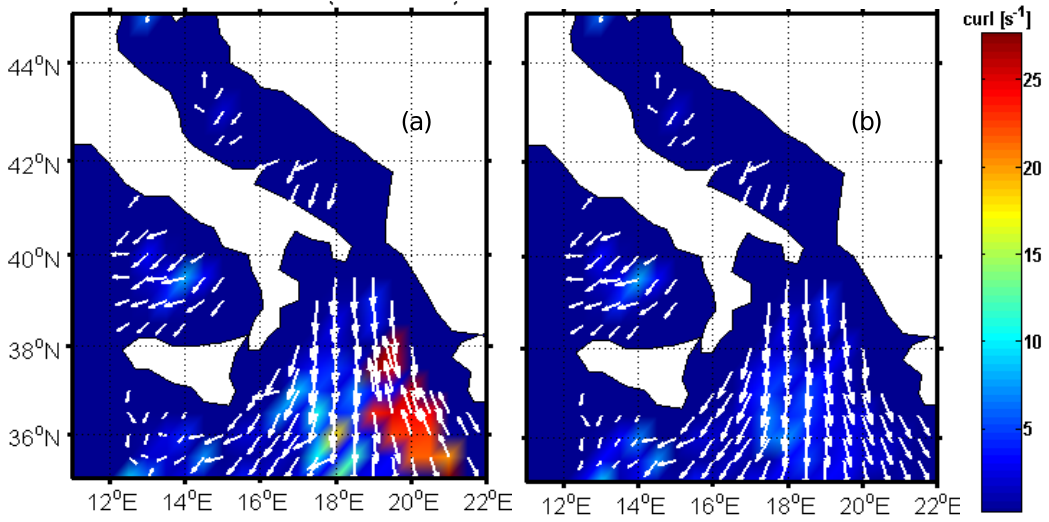
Figure 9 . Norm of the curl of the estimated wind field before (a) and after (b) the application of the proposed ambiguity selection